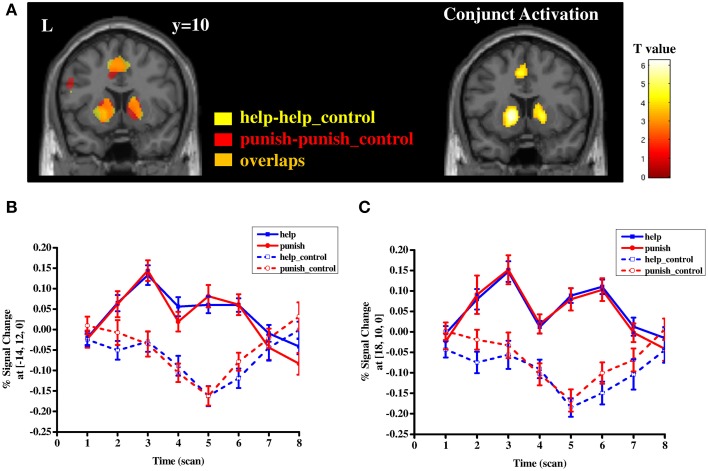
Separate and conjunction mapping of regions involved in third-party help and punishment (A) and timecourse of percent signal change in the local peak voxel of left striatum (B) and right striatum (C) in four conditions (i.e., help, help_control, punish, punish_control). Error bars: SEM.